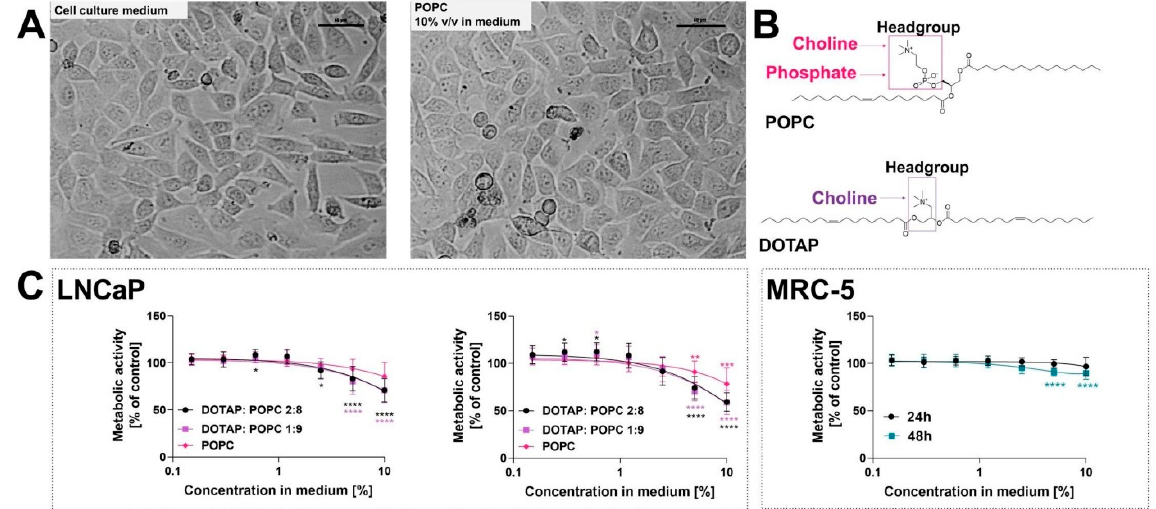
Figure 6. The cytotoxicity of the tested liposomal formulation. Panel ( A ) presents the cell morphology after incubation with POPC liposomes and cell culture medium after 48 h incubation time (represen- tative images). The images were taken with a DS-SMc digital camera attached to a Nikon Eclipse TS100 microscope. Scale bar corresponds to 50 µ m; panel ( B ) presents the chemical structure of 1-palmitoyl-2-oleoyl-sn-glycero-3-phosphocholine (POPC) and 1,2-dioleoyl-3-trimethylammonium- propane (DOTAP); panel ( C ) presents the effect of the tested empty liposomal formulations on cell viability. The DOTAP:POPC 1:9, DOTAP:POPC 2:8, and POPC liposomes were added to a cell culture medium at a concentration of 0.15–10% v / v for 24 and 48 h. The cell viability was measured by MTT assay. A cell culture medium was used as a control. The selected formulation was tested on a non-cancerous human lung fibroblast MRC-5 cell line. Data are expressed as the mean ± SD from five experiments (POPC, LNCaP), four experiments (DOTAP:POPC, LNCaP), and three experi- ments (for MRC-5). Statistical significance between groups was assessed by Dunnett’s Multiple